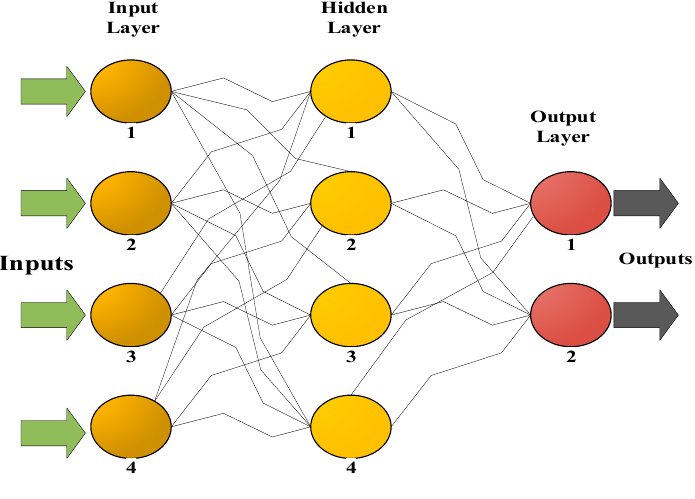
Figure 4. ANN Basic Architecture.